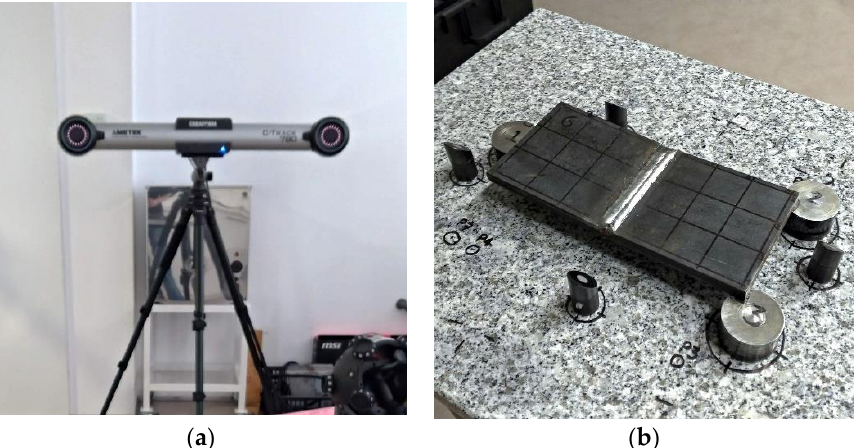
Figure 9. ( a ) C-Track measurement equipment and ( b ) arrangement positioning for data acquisition.